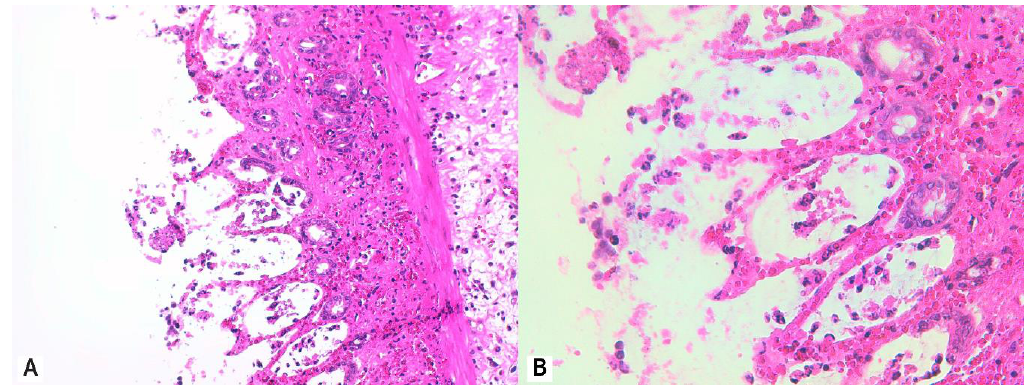
Figure 7. Colon histology of rats administered MSB (AA + MSB group). Colon tissue of rats that were administered MSB for 11 consecutive days prior to AA exposure was collected 24 h after AA exposure and demonstrated moderate inflammatory infiltrate in the mucosa and submucosa, few neutrophils in the lamina propria, neutrophil infiltration of crypt epithelium in <50% of crypts, unequivocal erosion with loss of epithelial lining, and distortion of glandular architecture with goblet cell depletion; H&E stain, 20× ( A ), 40× ( B ). Abbreviations: AA, acetic acid; H&E, hematoxylin and eosin; MSB, MegaSporeBiotic™.